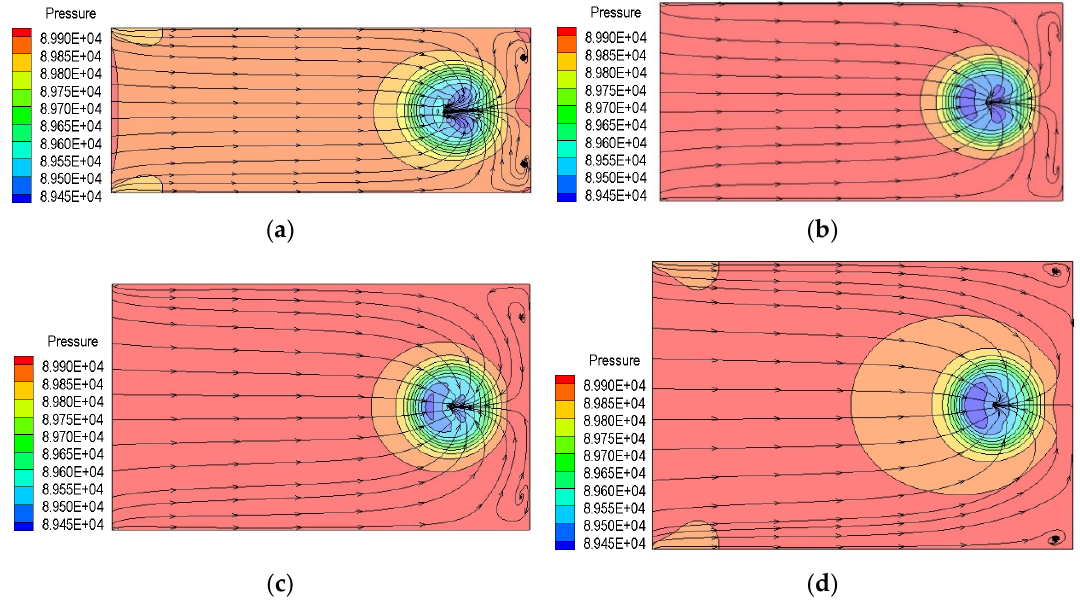
Figure 11. Pressure distribution of section 2-2 with different width. ( a ) Case 5, ( b ) Case 3, ( c ) Case 6 and ( d ) Case 7.